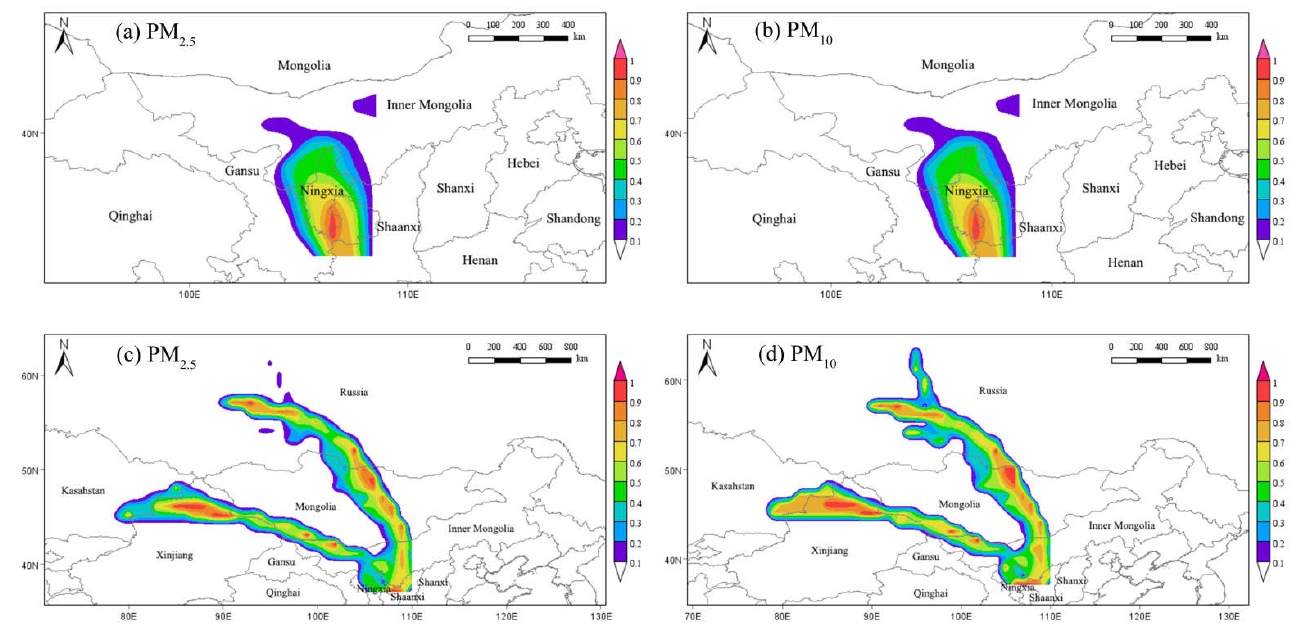
Figure 6. Weighted potential source contribution function (PSCF) for PM 2.5 and PM 10 during non- sandstorm ( a , b ) and sandstorm ( c , d ) intervals.